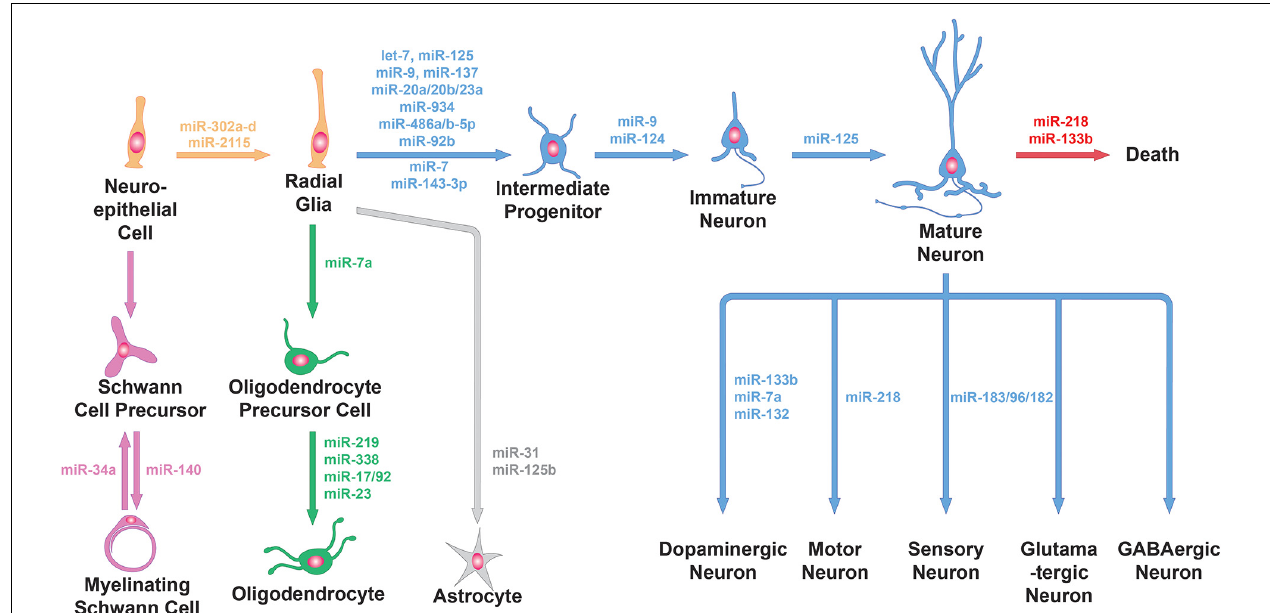
FIGURE 1 | miRNA functions in neural cell lineage. miRNAs are involved in the generation of progenitors from neuroepithelial cells, the differentiation of progenitor cells into neuronal or glial cells, the further specialization of neuronal cells and glial cells into specific subtypes and neuronal survival. Specific examples of miRNAs involved in these processes (e.g., miR-9 and miR-124 for neuronal differentiation, miR-31 for astrocyte differentiation, miR-218 for the specification and survival of motor neurons and miR-34a for Schwann cell dedifferentiation) are shown